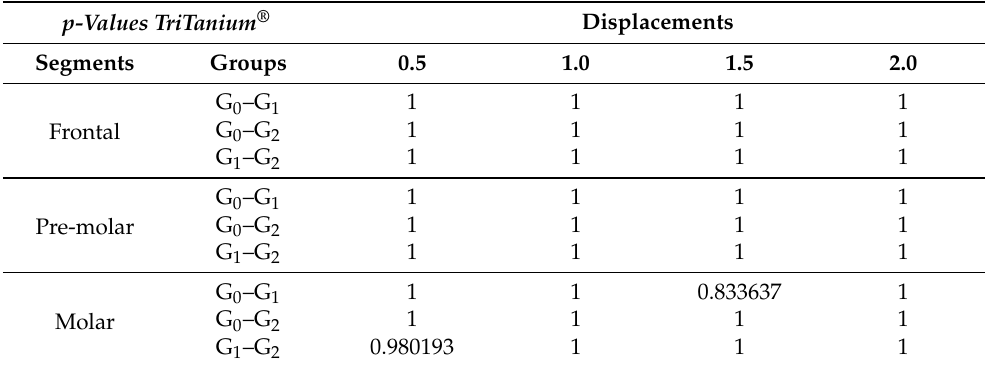
Table 4. TriTanium ® p -values, resulting from the statistical comparison of each segment in the G 0 , G 1 , G 2 periods of clinical use, at {0.5, 1.0, 1.5, 2.0} mm